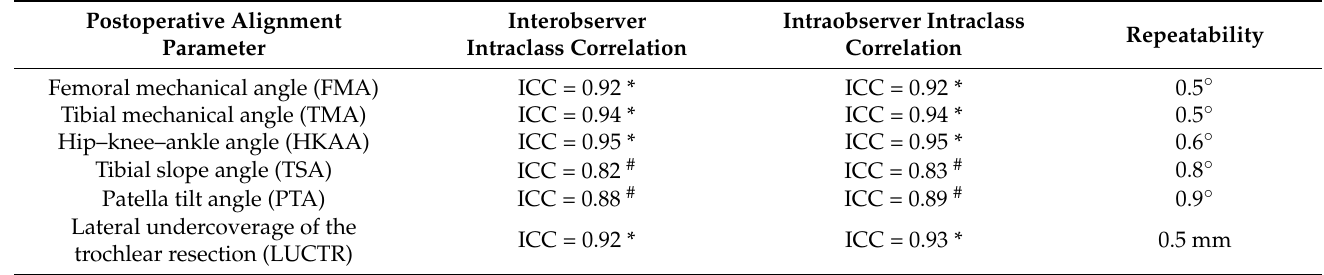
Table 2. The interobserver and intraobserver intraclass correlation coefficients (ICC values), repeata- bility, and agreement classification for measurements of the six postoperative alignment parameters.